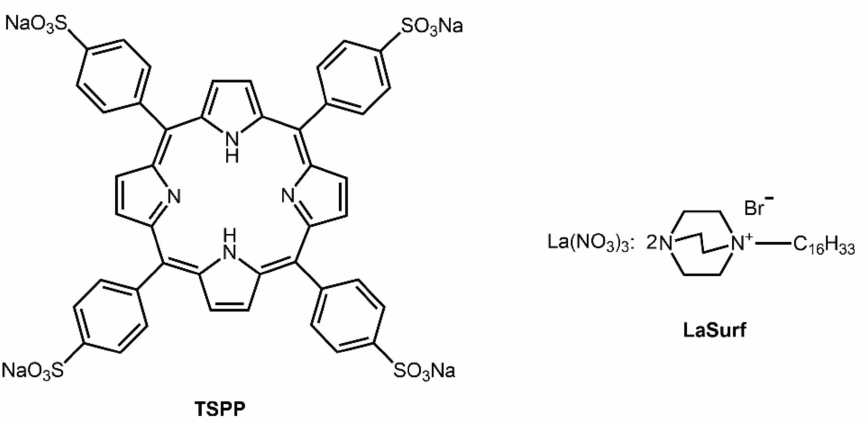
Figure 1. Chemical formulas of TSPP and